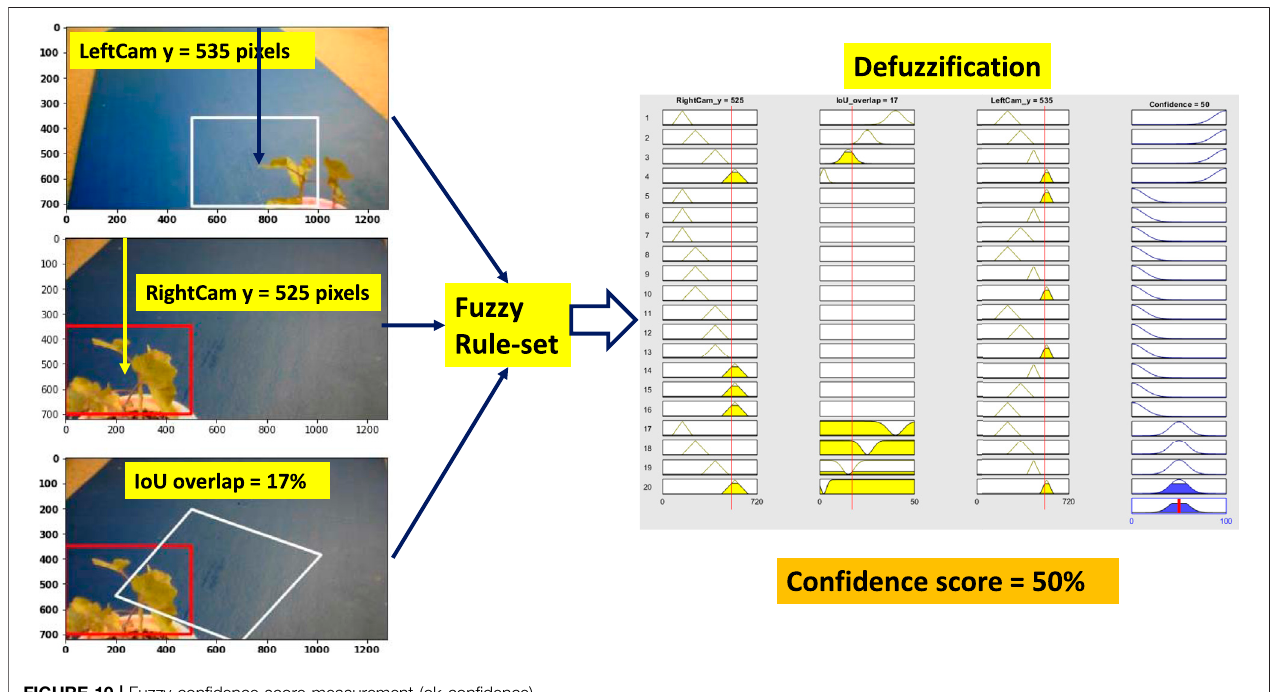
FIGURE 10 | Fuzzy con fi dence score measurement (ok con fi